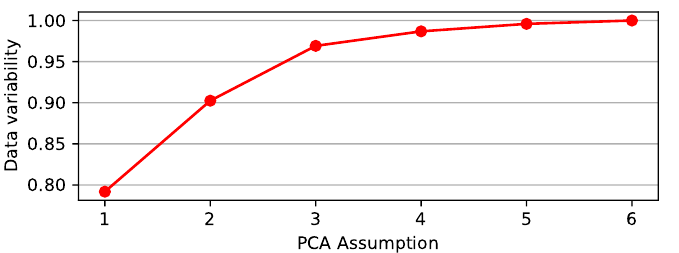
Figure 12. Percentage variability of the mobility reports data, which may be represented by